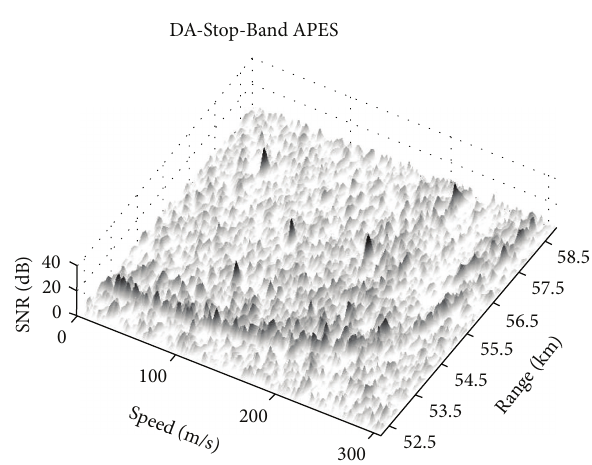
Figure 20: Comparison of Stop-Band STAP (dot curve) and Deter- ministic-Aided Stop-Band (solid curve) on air-air data at a distance of 58.5